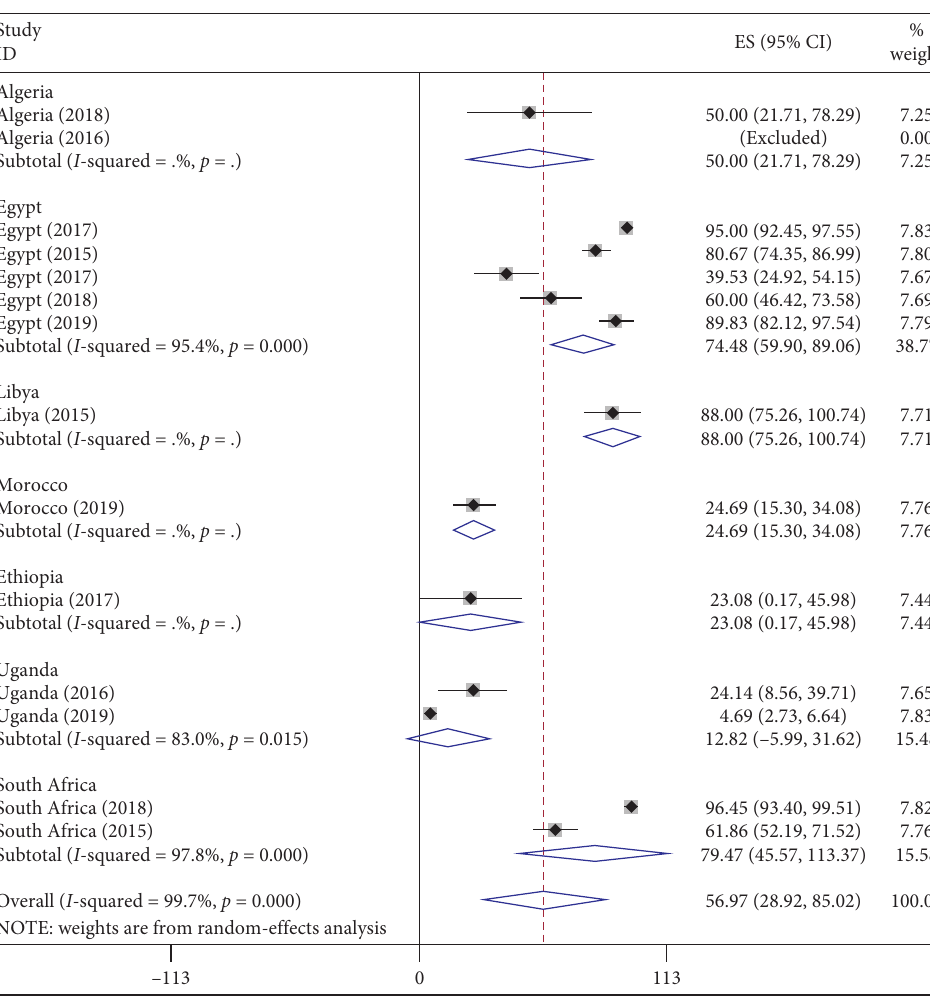
Figure 10: Subgroup analysis for the pooled prevalence of CPAB in Africa by country from 2007 to 2017